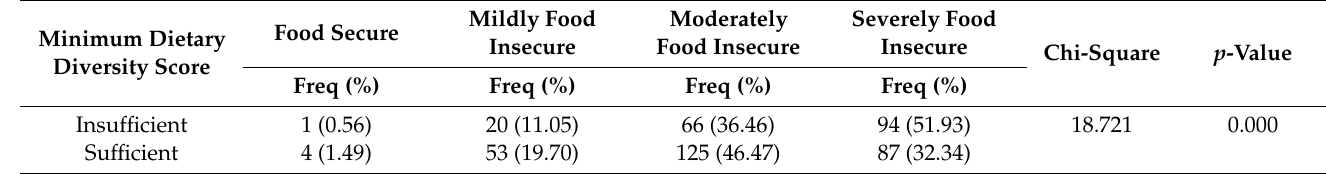
Table 5. Minimum dietary diversity score and household food security status of the preschool children.